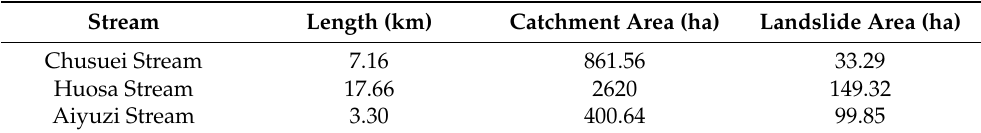
Figure 1. The terrain and landslide areas (after 2009) of the study area in Shemu [24]. Table 1. The landslide area in Shenmu after 2009 [1].